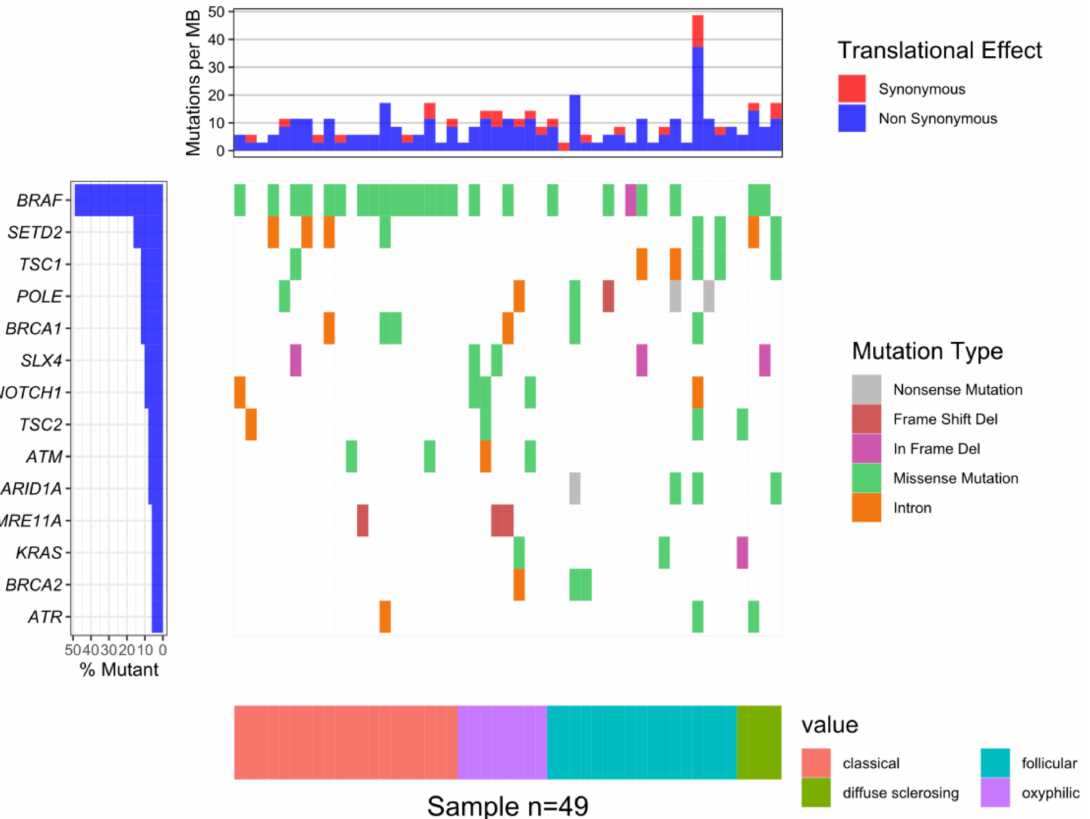
Figure 1. The waterfall plot of 14 genes in which mutations were identified in at least of 5% patients: BRAF—24 samples (49%); SETD2—8 (16%); TSC1, POLE, BRCA1—6 (12%); SLX4, NOTCH1—5 (10%); TSC2, ATM, ARID1A—4 (8%); MRE11A, KRAS, BRCA2, ATR—3